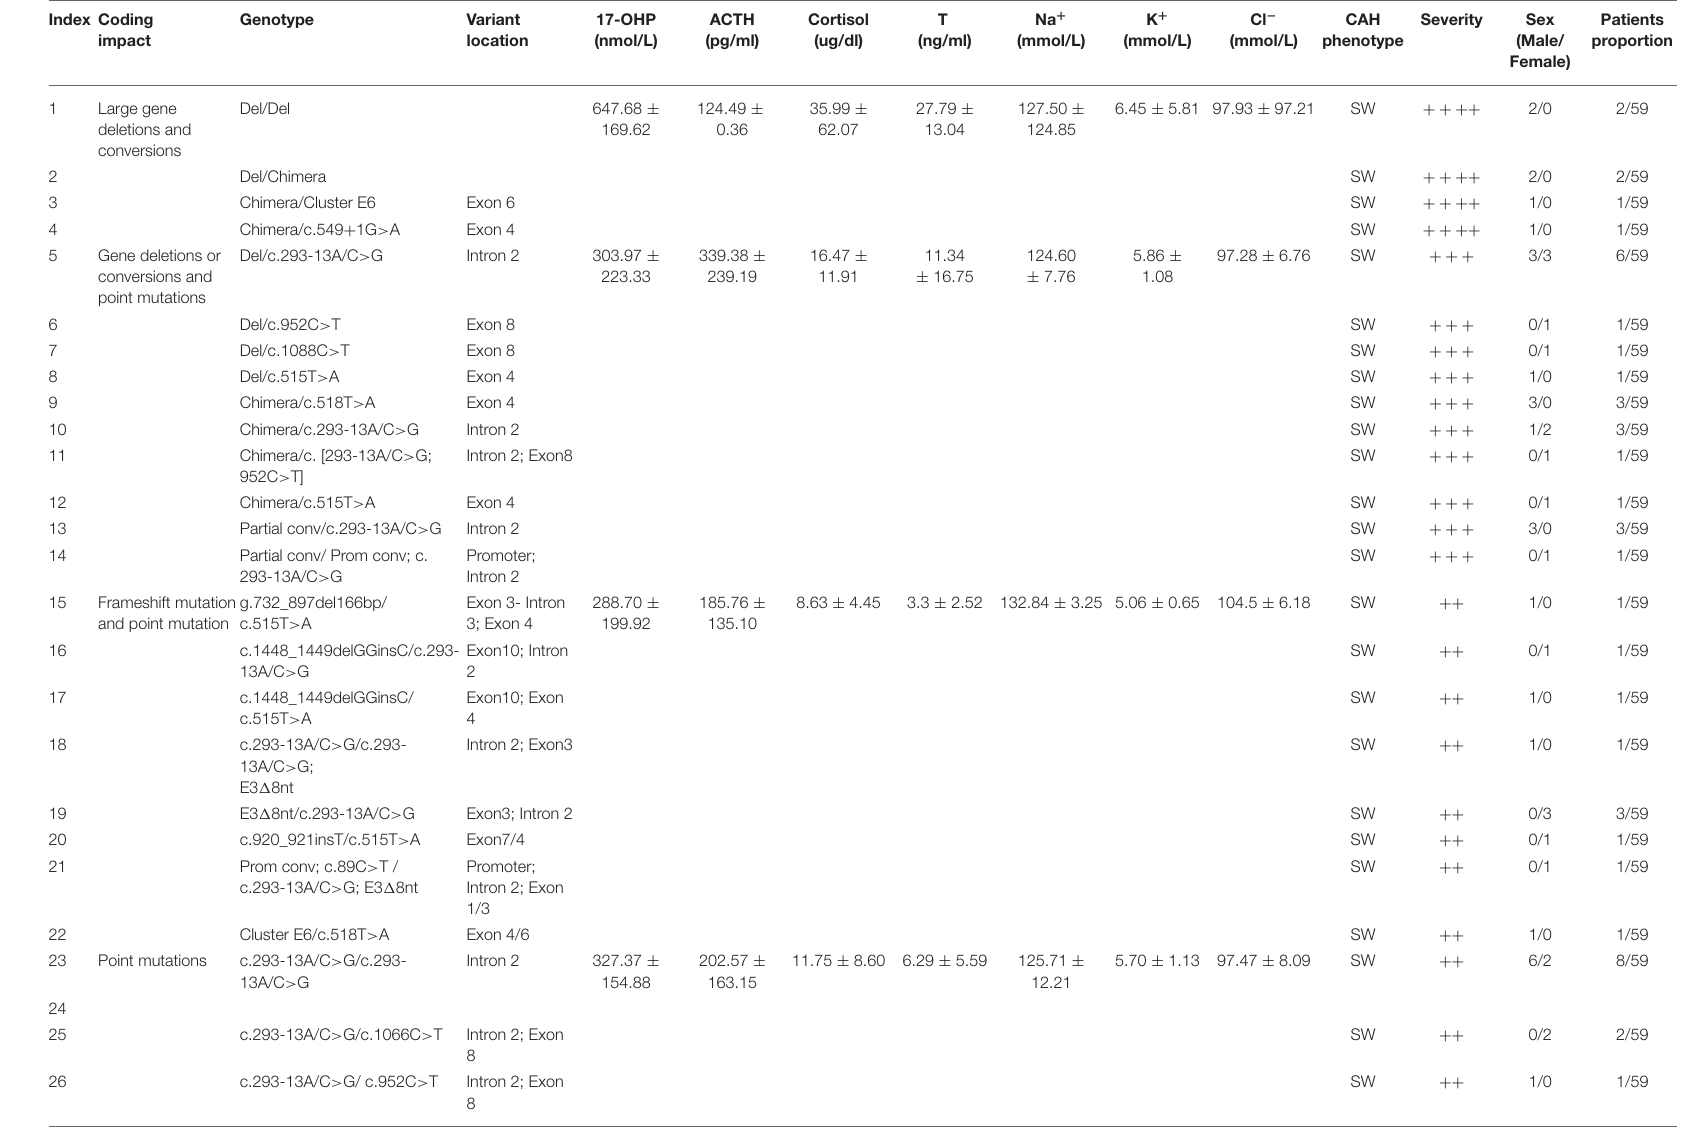
TABLE 4 | Variant distributions in 21-OHD